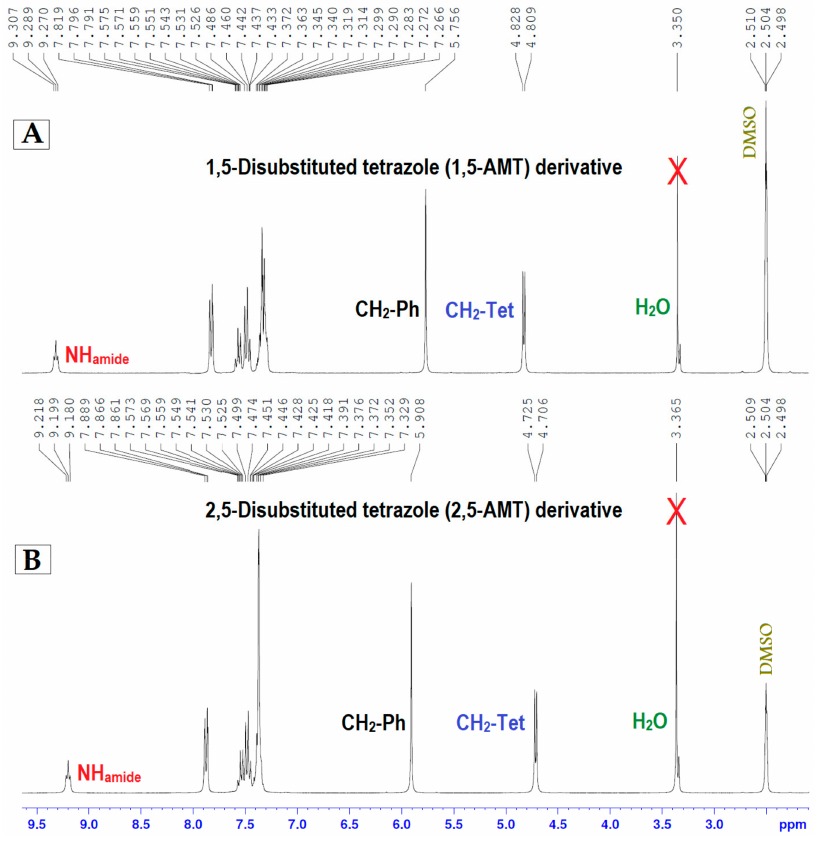
Figure 2. 1 H NMR spectra, ( A ) of 1,5-AMT and ( B ) of 2,5-AMT.